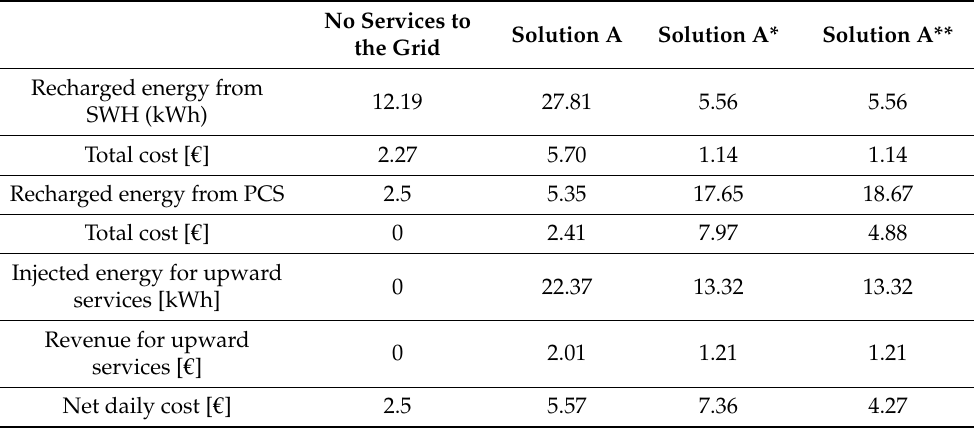
Table 17. Results of different solutions for mobility pattern 1—UVAM.